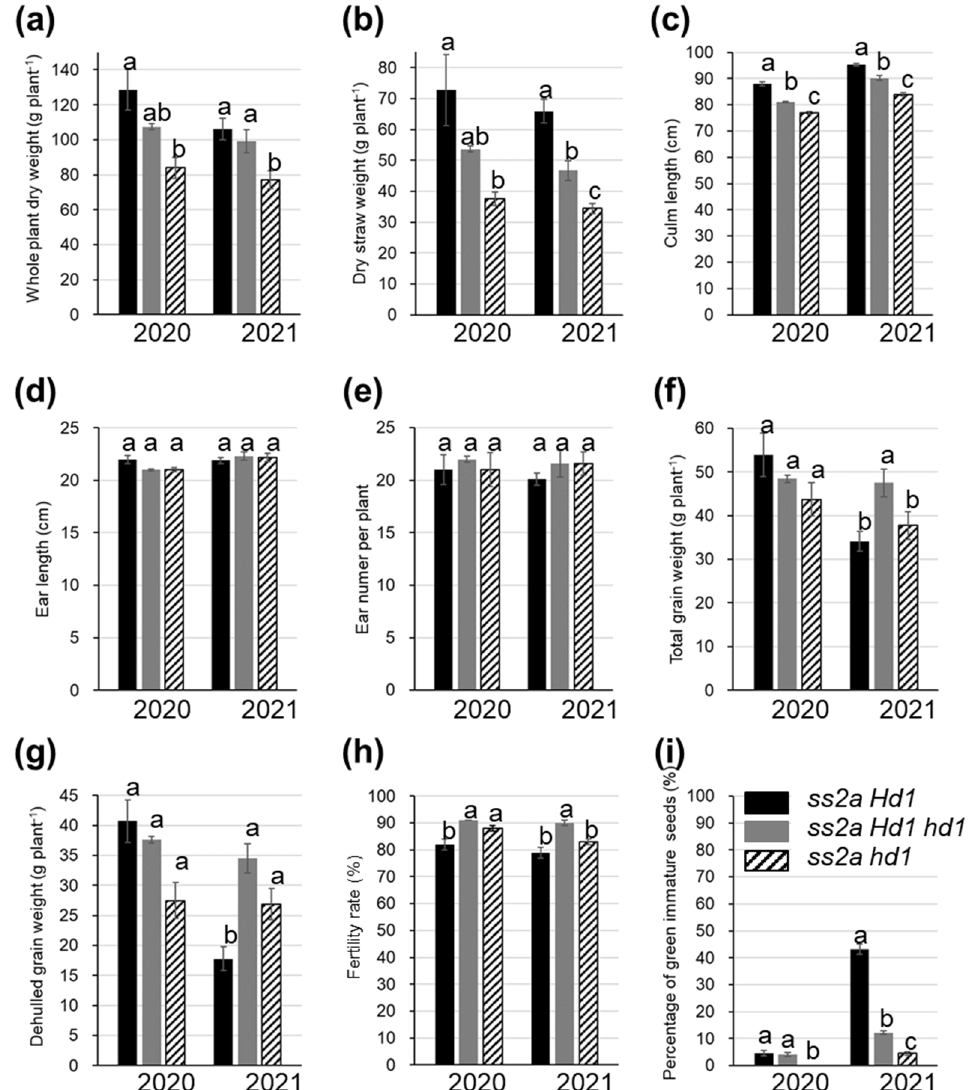
Figure 6. Agricultural traits of ss2a Hd1 (black), ss2a Hd1 hd1 (gray), and ss2a hd1 (stripe) NILs. ( a ) Whole-plant dry weight, ( b ) dry straw weight per plant, ( c ) culm length, ( d ) ear length, ( e ) ear number per plant, ( f ) total grain weight per plant, ( g ) dehulled grain weight per plant, ( h ) fertility rate, ( i ) percentage of green immature seeds. Data represent mean ± standard error (SE). The three bars on the left represent data from 2020, and those on the right represent data from 2021. Data collected during the same harvest year were statistically analyzed via the Tukey ‒ Kramer method ( p < 0.05). The number of ss2a Hd1 , ss2a Hd1 hd1 , and ss2a hd1 plants was 9, 20, and 8, respectively, in 2020, and 20 plants of each line were analyzed in 2021. Different lowercase letters above bars indicate significant differences.